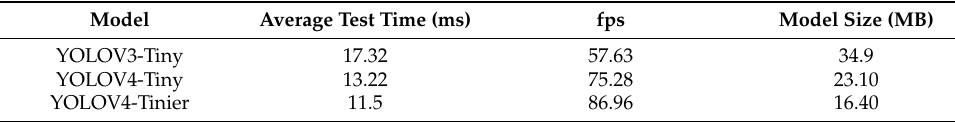
Table 3. Comparison of the real-time performance.